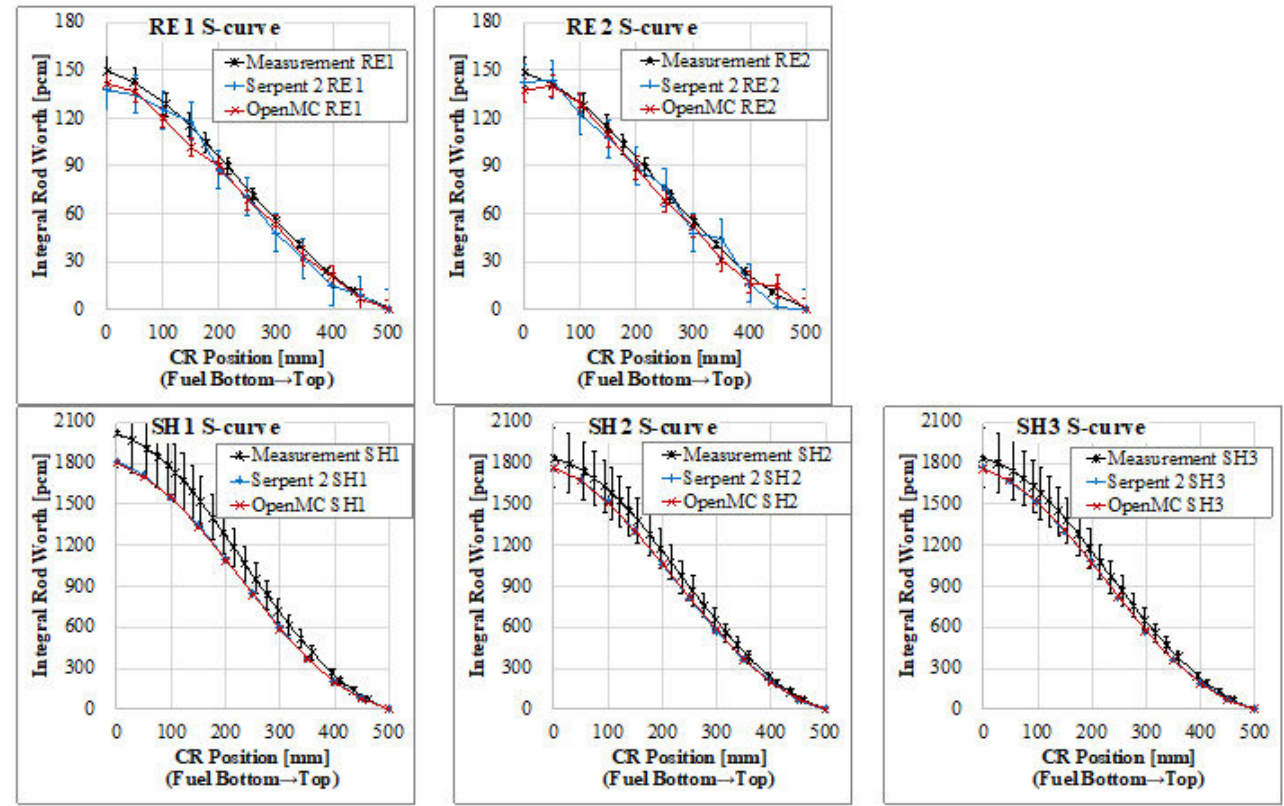
Figure 9. S-curves of regulating rods ( RE1 , RE2 ) and shim rods ( SH1 , SH2 , SH3 ). The standard of the bottom is the bottom of the fuel